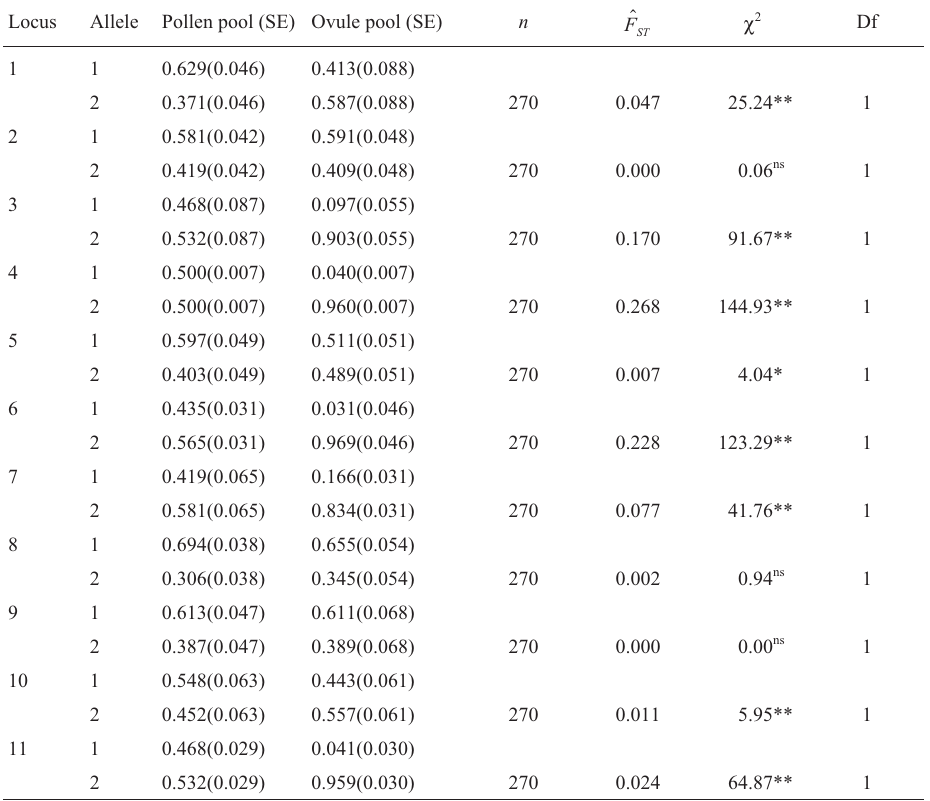
Table 1 - Maximum likelihood estimates of pollen and ovule allele frequencies in the progeny of M. urundeuva . Locus Allele Pollen pool (SE) Ovule pool